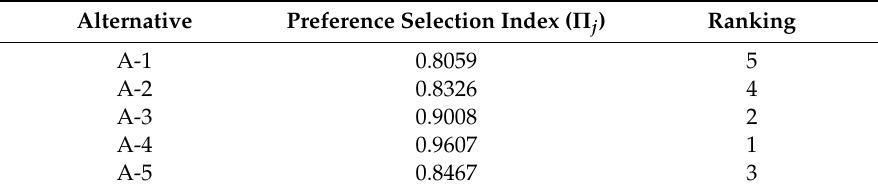
Table 6. The preference selection index ( Π j ) and its alternatives